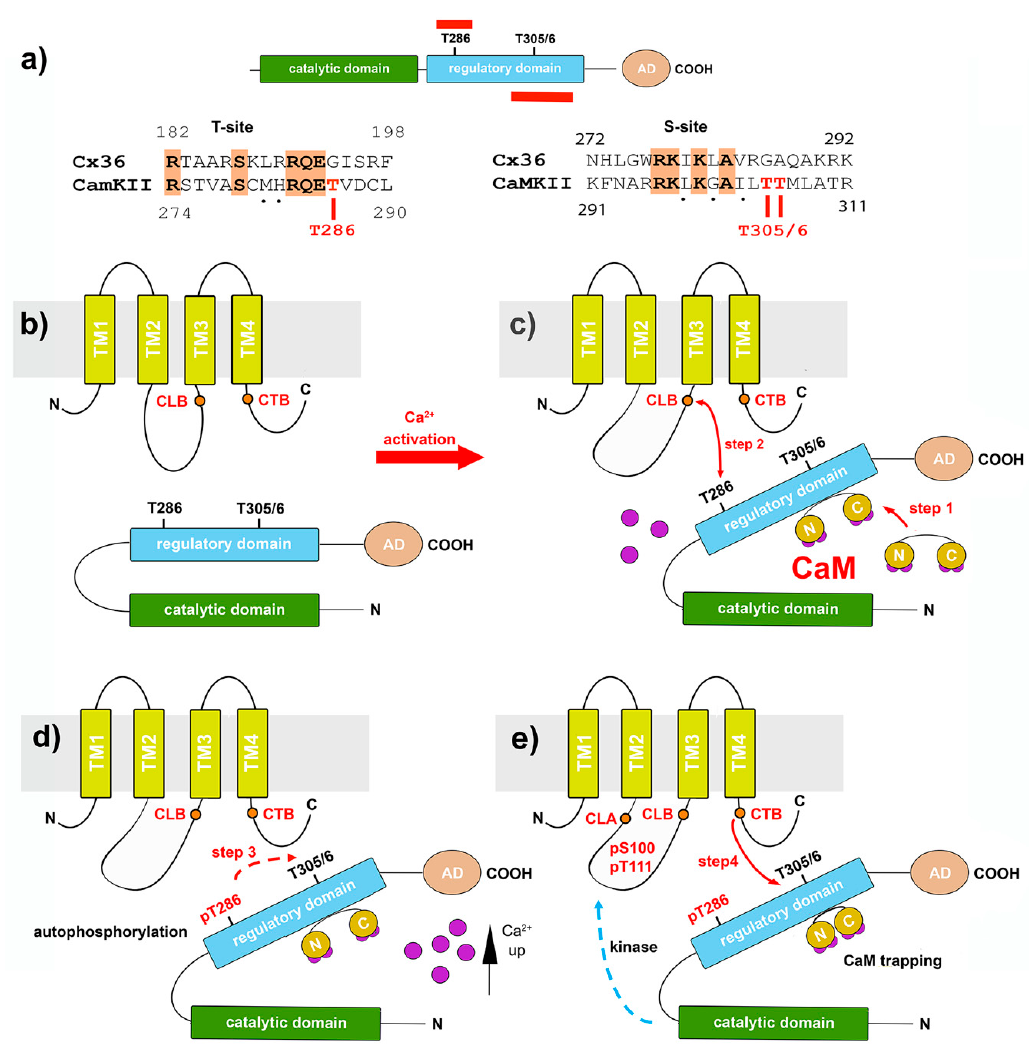
Figure 3. The Cx36–CaMKII -binding complex. ( a ) The catalytic, regulatory, and accessory domain of CaMKII . The autophosphorylation and T-site (top) and the CaM -binding site at the S-site are shown (bottom) in red. T286 and T305/6 indicated phosphorylation sites in the regulatory domain. The sequence alignments below show conserved amino acids in the T- and S-sites of Cx36 and CaMKII . ( b – e ) Model of the activation sequence in which CaMKII is opened by calcium-activated CaM , followed by the sequential binding and phosphorylation of Cx36 (modified from reference [53]). ( c ) In step 1, elevated intracellular Ca 2+ activates CaM , and the binding of Ca 2+ /CaM to the autoinhibitory domains displaces the gate and, in step 2, allows the CaMKII -binding domain in the cytoplasmic loop of Cx36 (CLB) to interact with the kinase’s target site, CaMKII . ( d ) Autophosphorylation at T286 (step 3) ( e ) enables the kinase to bind to a domain in the carboxyl terminus of Cx36 (labeled CTB) (step 4). Phosphorylation of the cytoplasmic loop sites follow (dashed blue arrow in ( e )), as well as in the carboxyl terminal